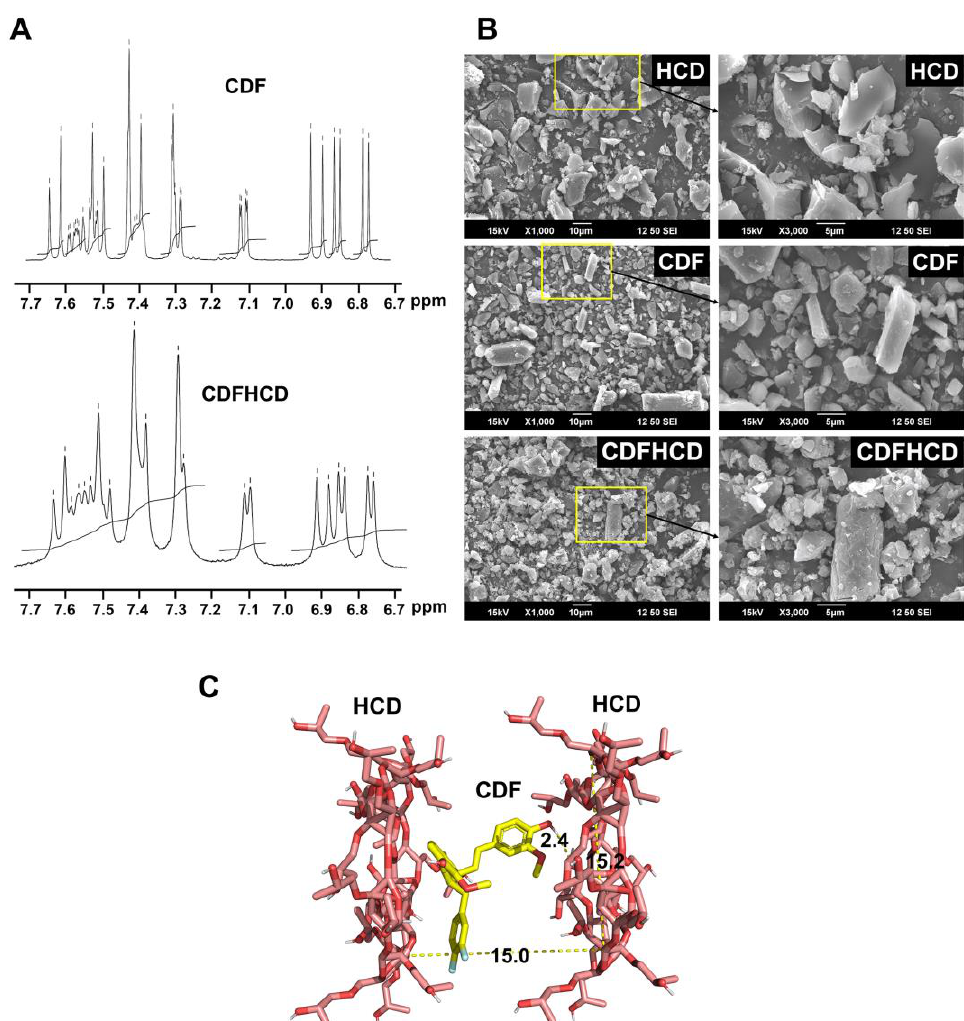
Figure 2. Morphological characterization of CDFHCD complex and the interactions of the CDF within the cyclodextrin cavity. ( A ). NMR spectra of 2- HCD, CDF, and CDFHCD inclusion complex. ( B ). SEM images of 2- HCD, CDF, and CDFHCD inclusion complex. ( C ). The binding mode of CDF in the cavity of HCD was proposed using molecular docking.